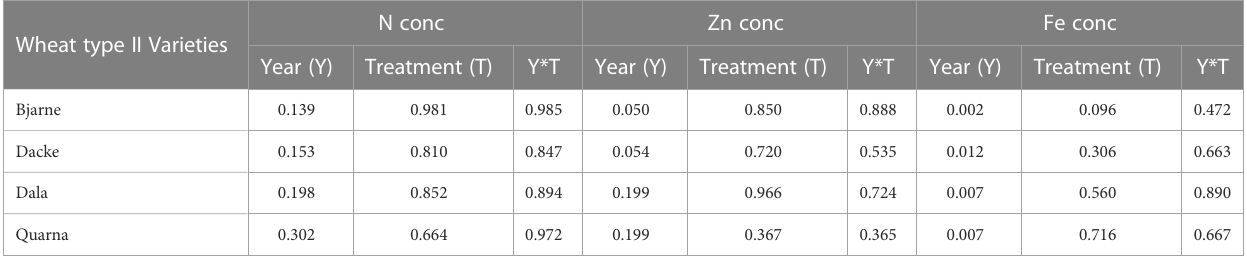
TABLE 5 Analysis of variance (ANOVA) p-value for N, Zn and Fe for fi xed effects related to environmental variation of the four varieties in high protein wheat type (II).